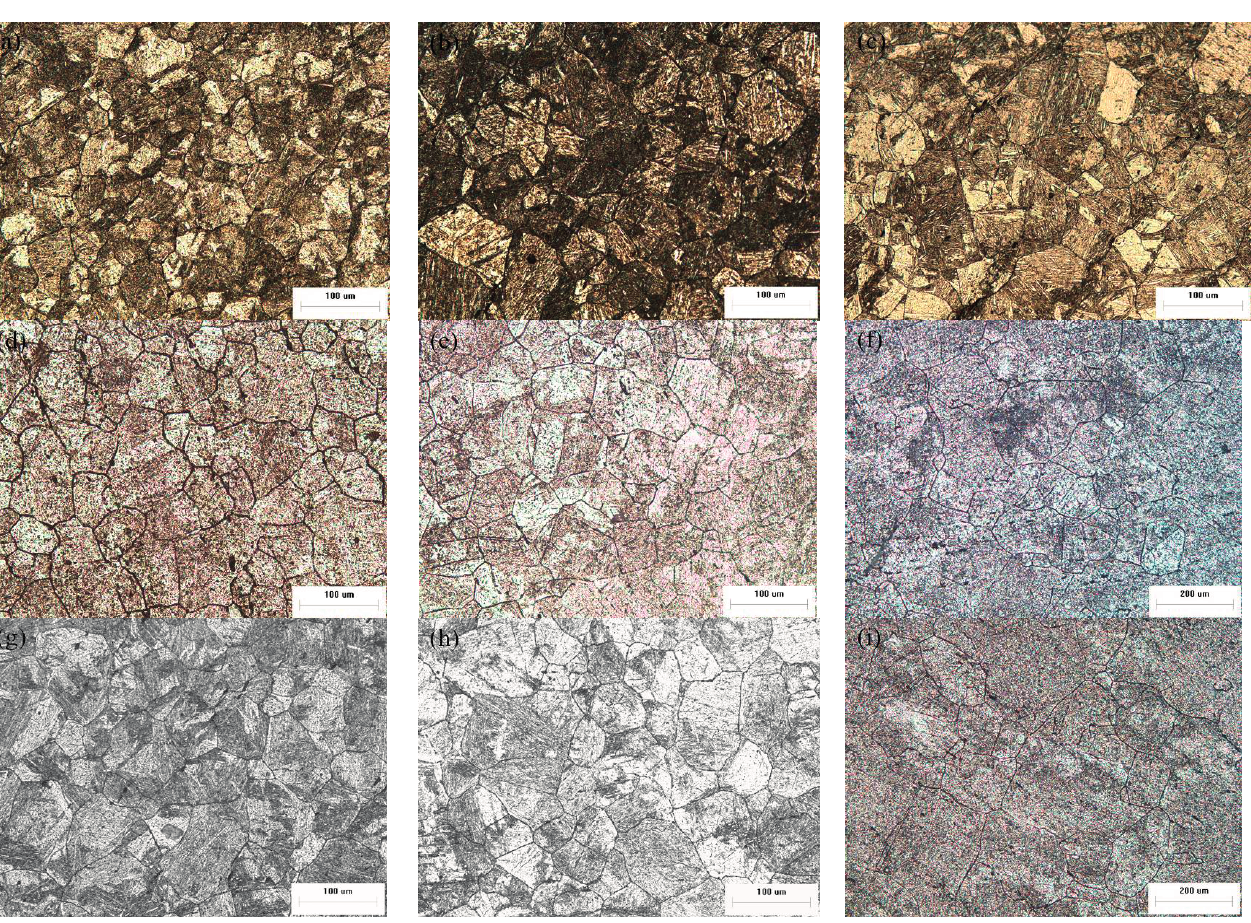
Figure 1. Optical micrographs of initial austenite grain at different austenitizing temperatures: ( a ) B1, 1050 °C; ( b ) B1, 1100 °C; ( c ) B1, 1150 °C; ( d ) B2, 1050 °C; ( e ) B2, 1100 °C; ( f ) B2, 1150 °C; ( g ) B3, 1050 °C; ( h ) B3, 1100 °C; ( i ) B3, 1150